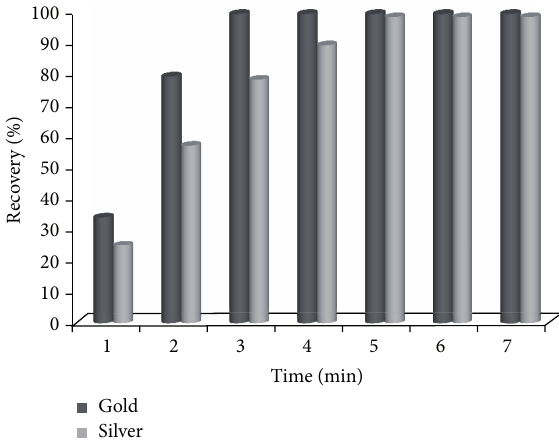
T 3: e tolerance limit of the diverse ions on the determination of silver and gold ions. Interfering ions Tolerable concentration for AgX/Ag Recovery, Tolerable concentration for AuX/Au